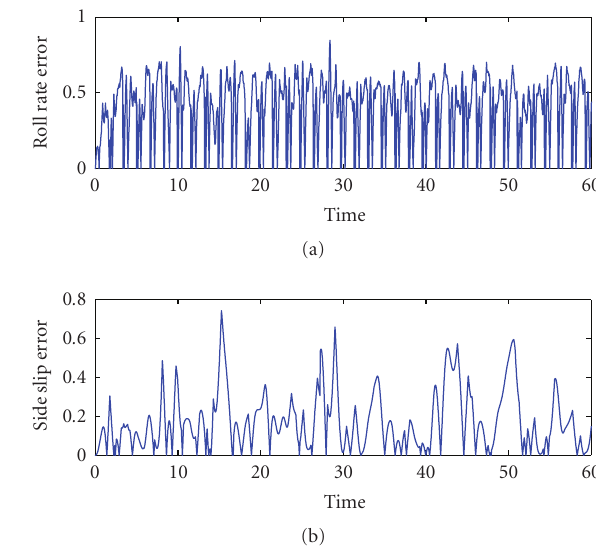
Figure 6: The trajectories of matching errors.